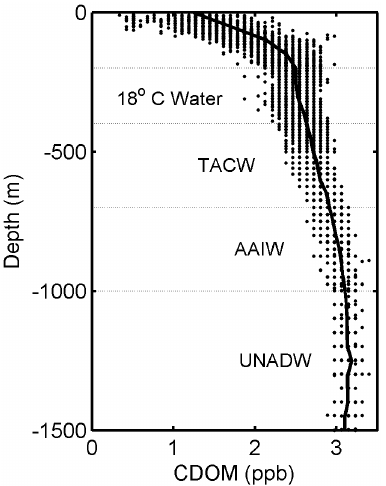
Figure 6. CDOM from all float profiles overlaid with the major Gulf of Mexico water masses below 200 m. The primary deep water masses include: 18 u C Sargasso Sea water (200–400 m), Tropical Atlantic Central water (TACW, 400–700 m), Antarctic Intermediate Water (AAIW, 700–1,000 m), and Upper North Atlantic Deepwater (UNADW, , 1,000 m and greater) [19]. Mean CDOM values for all profiles is indicated (solid black line). Note that all CDOM . 3.5 ppb were removed from this figure and associated mean, to remove anomalies due to high near-bottom values.